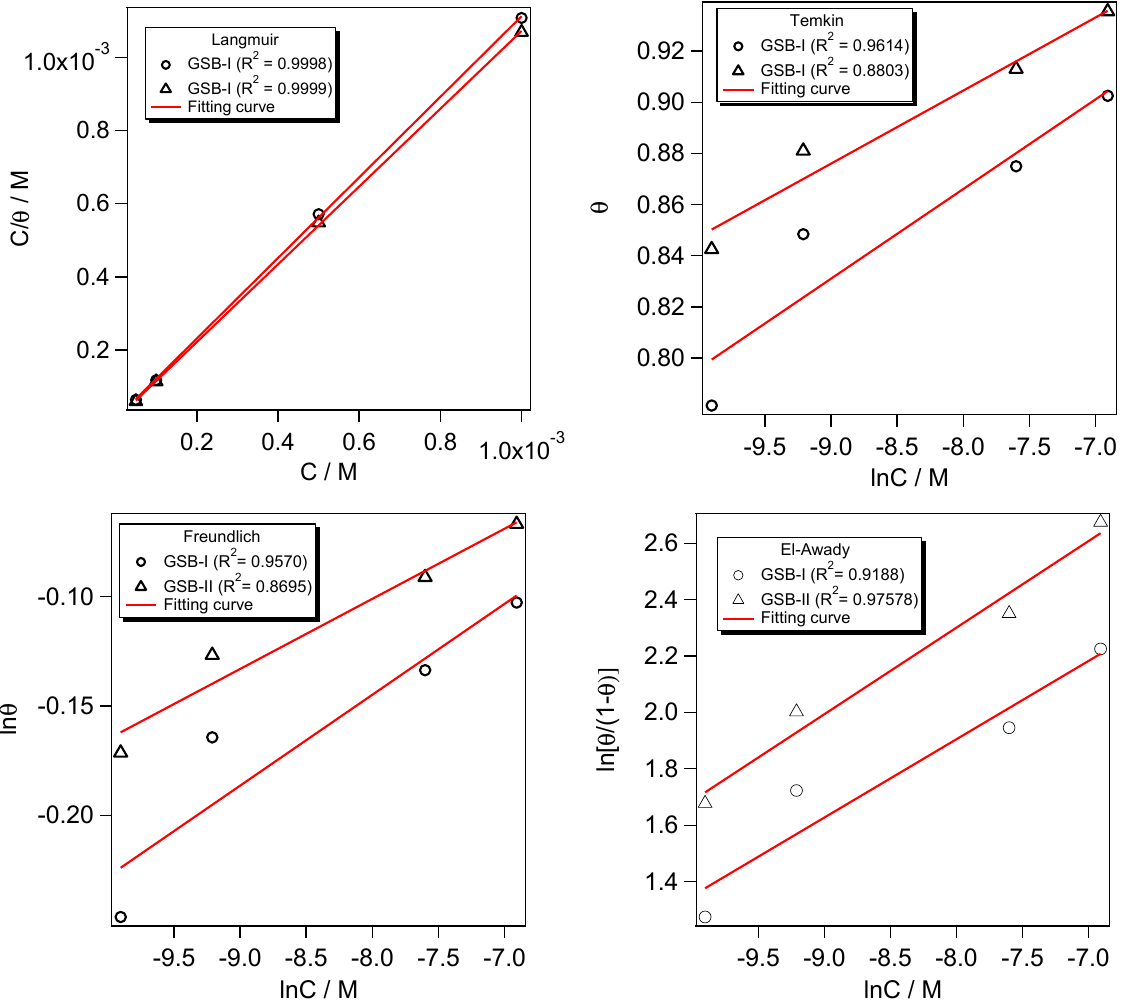
Figure 6. Plots of Langmuir, Temkin, Freundlich, and El-Awady isotherms for studied inhibitors at different concentrations.